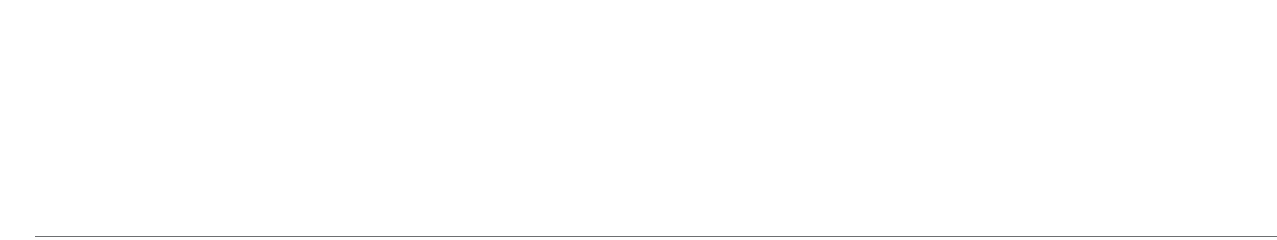
Frontiers in Bioengineering and Biotechnology |